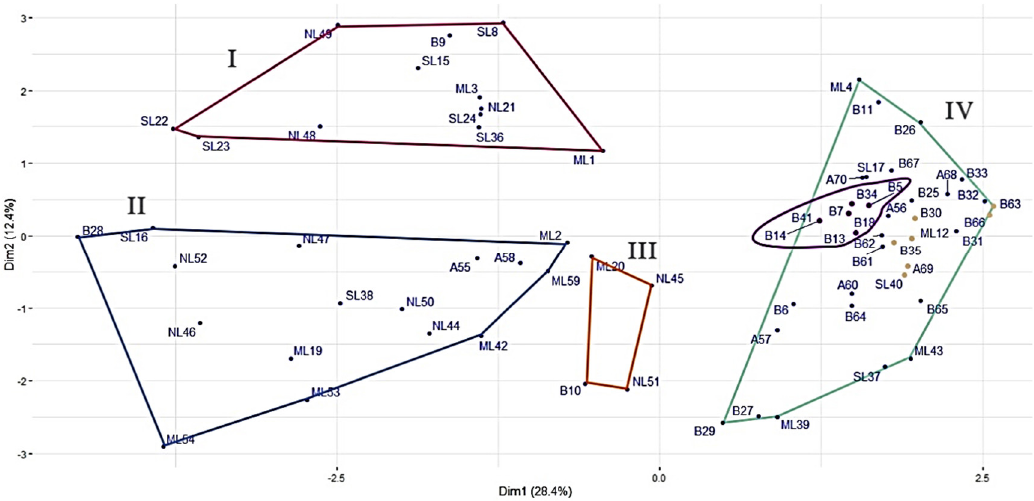
Figure 4. Cluster diagram constructed on the basis of the first two principal component axes containing 40.81% of total variation in Lebanese snake melon accessions. The small subgroup in group IV is composed of seven accessions distinguished by their long and elongated fruits, strong fruit ribs, white flesh color, and slight fruit sweetness.